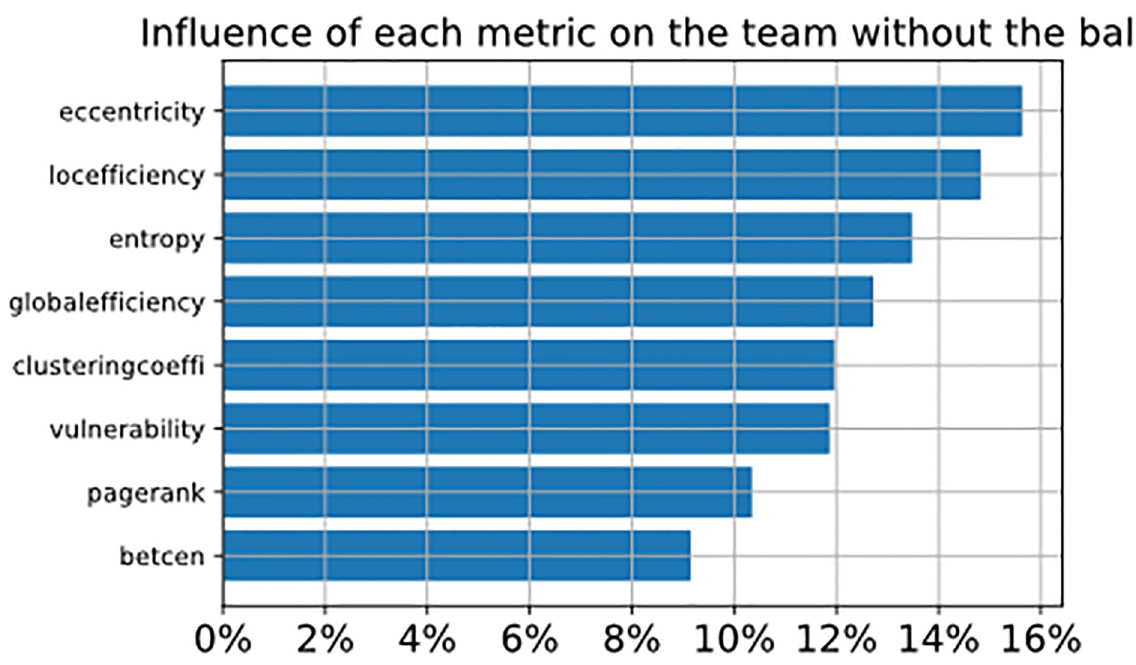
Fig 13. The figure shows the SHAP values of metrics of the defending team.